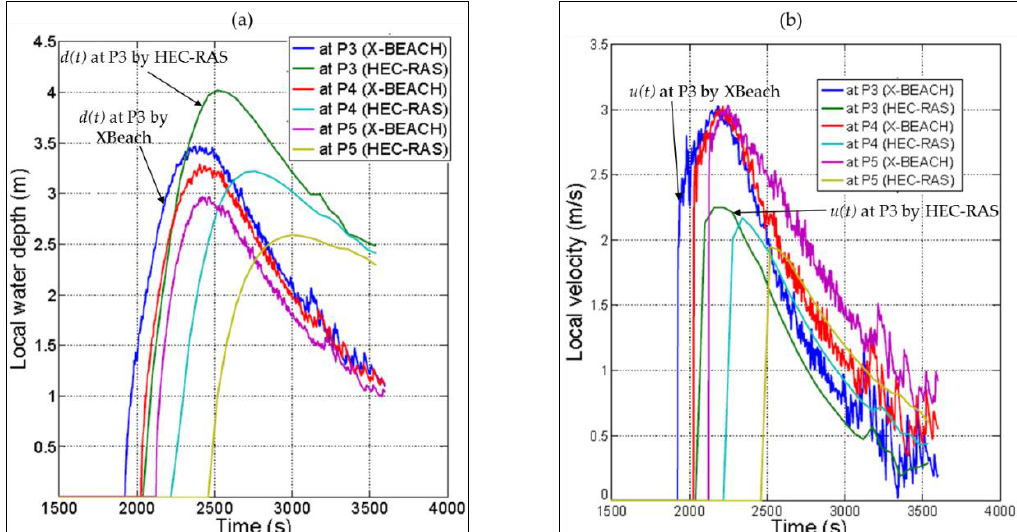
Figure 11 . Comparison of local water depths ( a ) and local depth-averaged velocities ( b ), calculated by both HEC-RAS and XBeach (1D) at the measuring point P3, P4 and P5 under the triangular load (LC2).